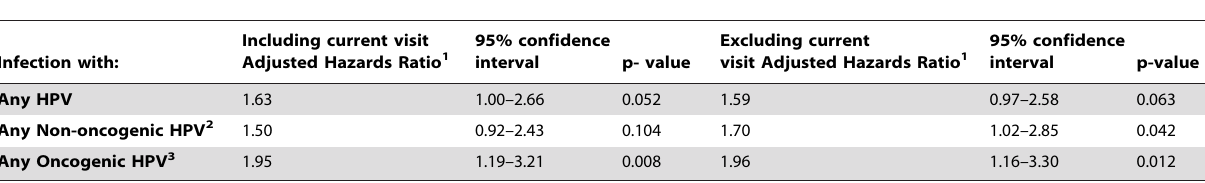
Table 5. Recent HPV infection (within 6 months of HIV acquisition visit) as a predictor of HIV acquisition.